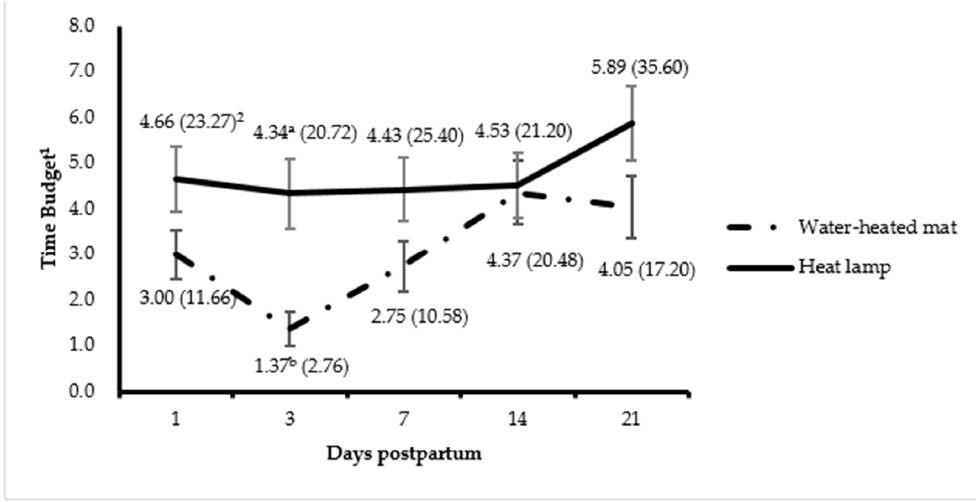
Figure 3. Time spent by piglets lying off the heat mat or away from the heat lamp over 21 days. 1 Time spent lying outside water-heated mats or heat lamps as a percentage of total observation time (24 h for each day). 2 Least square means (LSM) of raw data not distributed normally are displayed with square root transformed LSM with raw LSM in parenthesis. ab Least square means within a day without a common superscript differ ( p < 0.05).